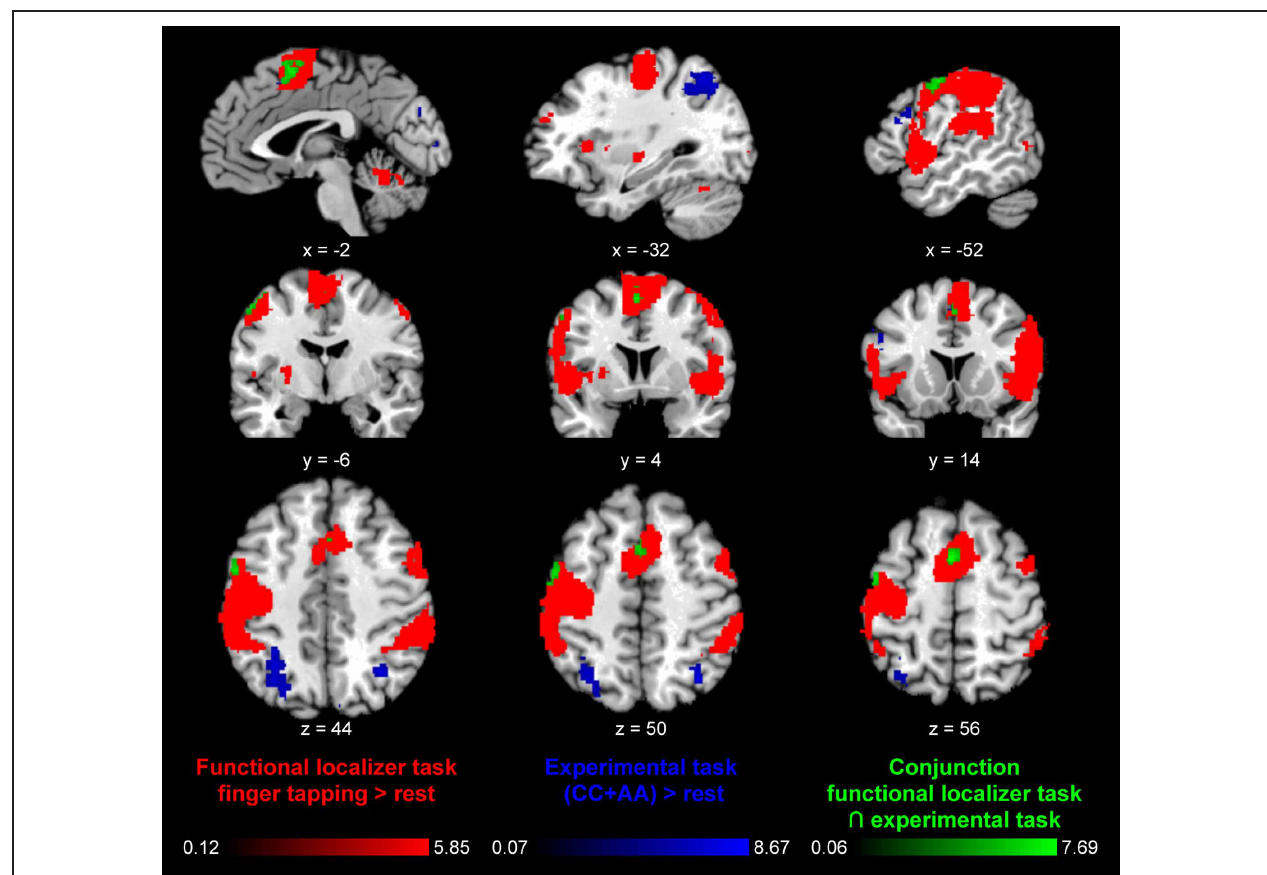
FIGURE 2 | Absolute activations resulting from functional localizer task and experimental task. Activations from finger tapping task compared to rest (red), activations from the presentation of abstract and concrete multi-word expressions (CC + AA) in the experimental task compared to rest (blue), and overlapping areas of the functional localizer task and the